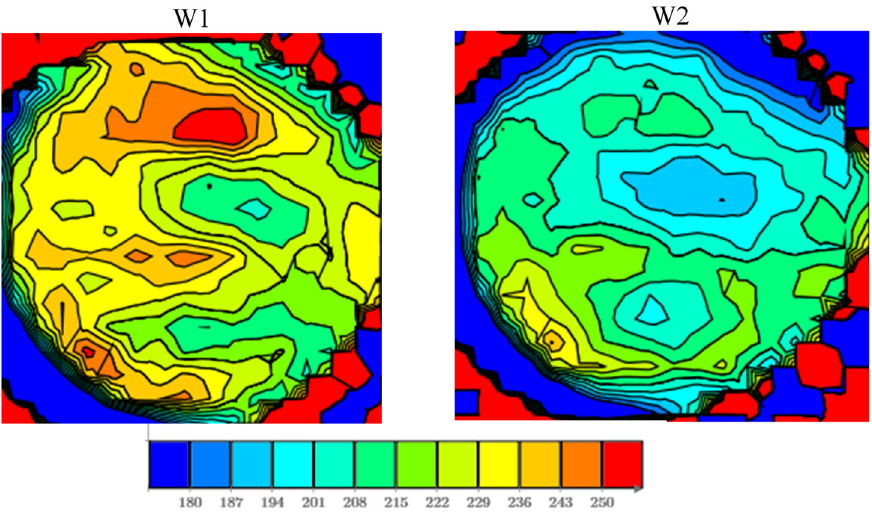
Figure 7. Sheet resistance contour maps for two 200 mm diameter wafers. W1: Mean value 223.2 Ω , Figure 7 . Sheet resistance contour maps for two 200 mm diameter wafers. W1: Mean value 223.2 standard deviation ± 19.9 Ω . W2: Mean value 202.1 Ω , standard deviation ± 15.1 Ω Ω , standard deviation ± 19.9 Ω . W2: Mean value 202.1 Ω , standard deviation ±15.1 Ω .